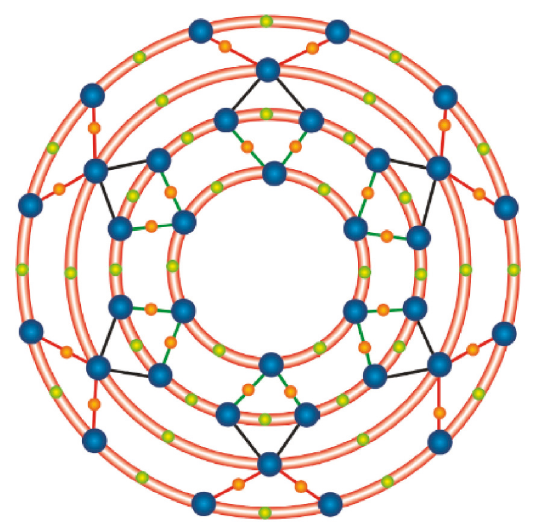
Figure 1: Metal organic network with 2 layers or MON(2) [47,48].